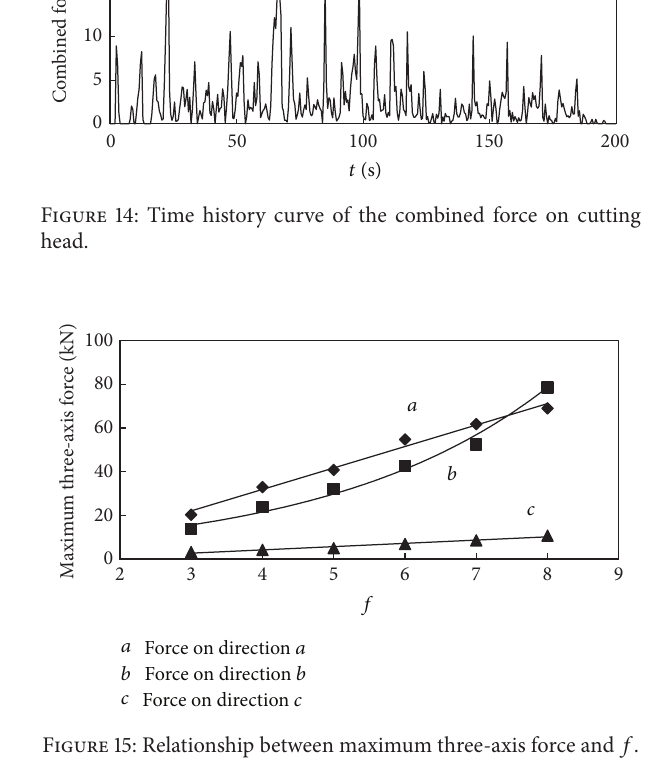
Figure 15: Relationship between maximum three-axis force and 𝑓